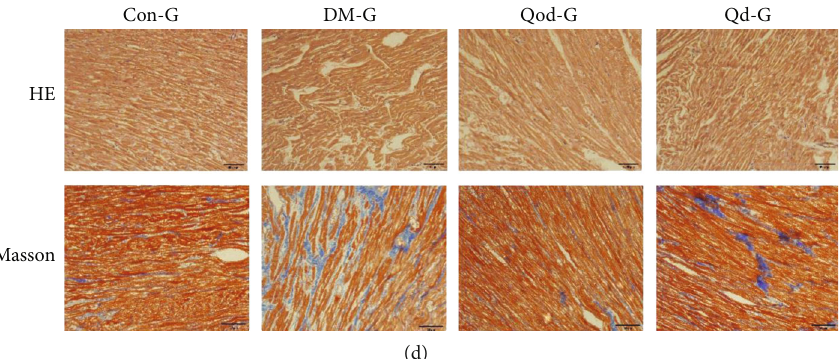
Figure 1: Curcumin inhibits ferroptosis and improves myocardial fi brosis. (a) The expression levels of ferroptosis-related proteins in each group were detected by western blotting. The results showed that curcumin signi fi cantly inhibited the expression of ferroptosis-related proteins ( ∗ P < 0 : 05 ). Data are expressed as mean ± SD . (b) Immuno fl uorescence staining of rabbit myocardium for Gpx4 protein expression ( × 200). (c) Collagen immuno fl uorescence staining in rabbit myocardial tissue ( × 200). (d) Hematoxylin and eosin and Masson staining of rabbit myocardial tissue demonstrating how curcumin signi fi cantly inhibits glucose-induced myocardial fi brosis ( ×